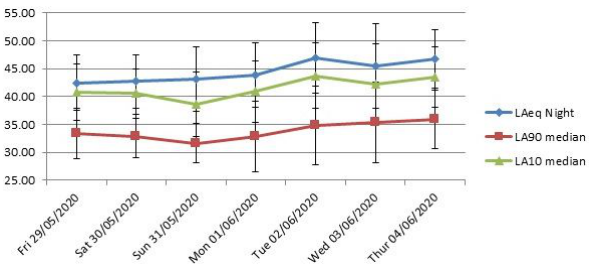
Figure 6: Case Study A: Night-time noise levels +/ − 1 standard deviation